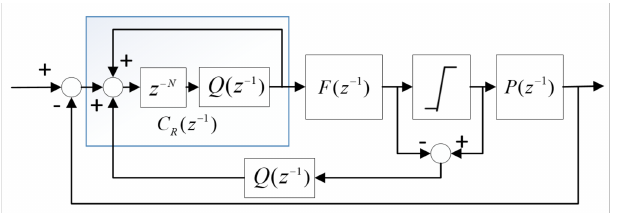
Figure 8. Block diagram of the repetitive controller with anti-windup structure.